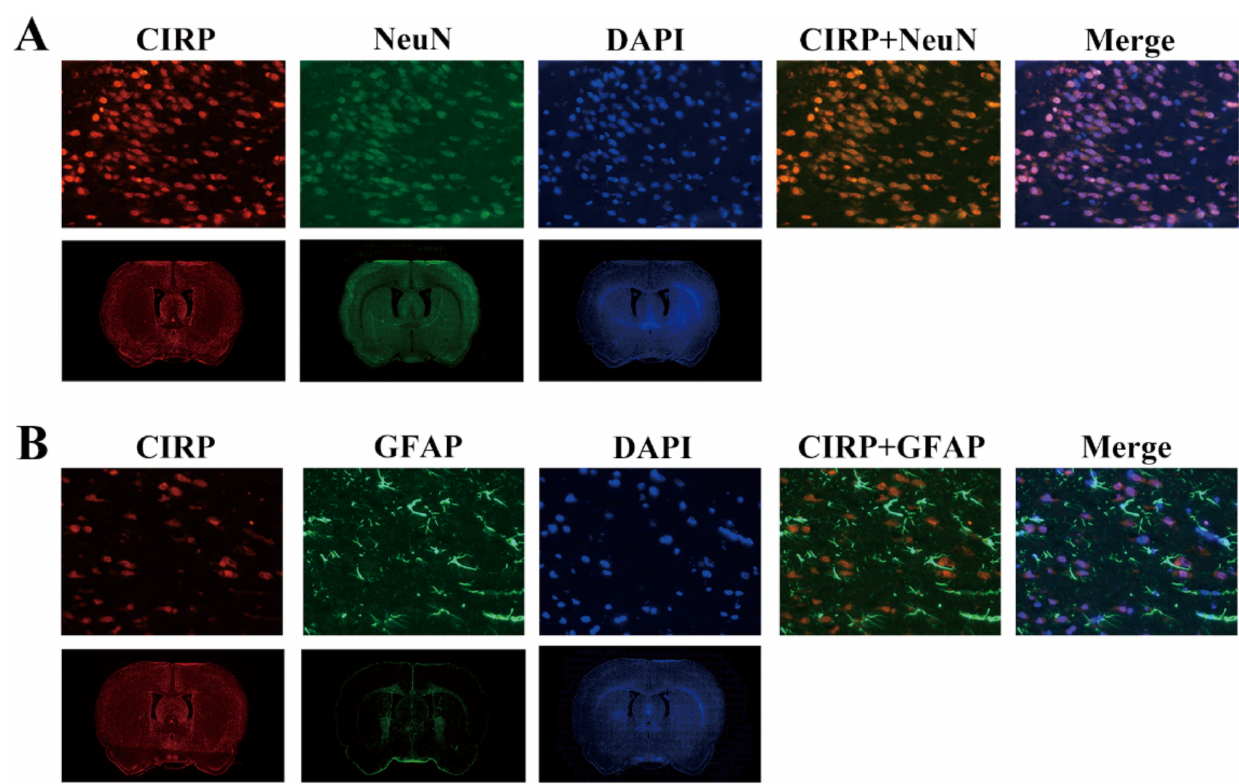
Figure 4. The distribution of CIRP in the rat brain tissue 1 d after SAH induction as determined by immunofluorescence staining. ( A ) Co-staining with NeuN; ( B ) Co-staining with GFAP. Micrographs in the top panels at a magnification of × 400. Bottom panels show the whole cerebral coronal